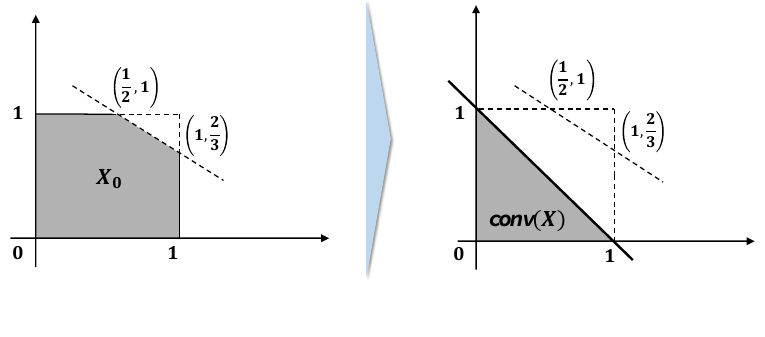
Figure 3. Illustration of polytope X 0 ( left ) and its convex hull conv ( X ) ( right